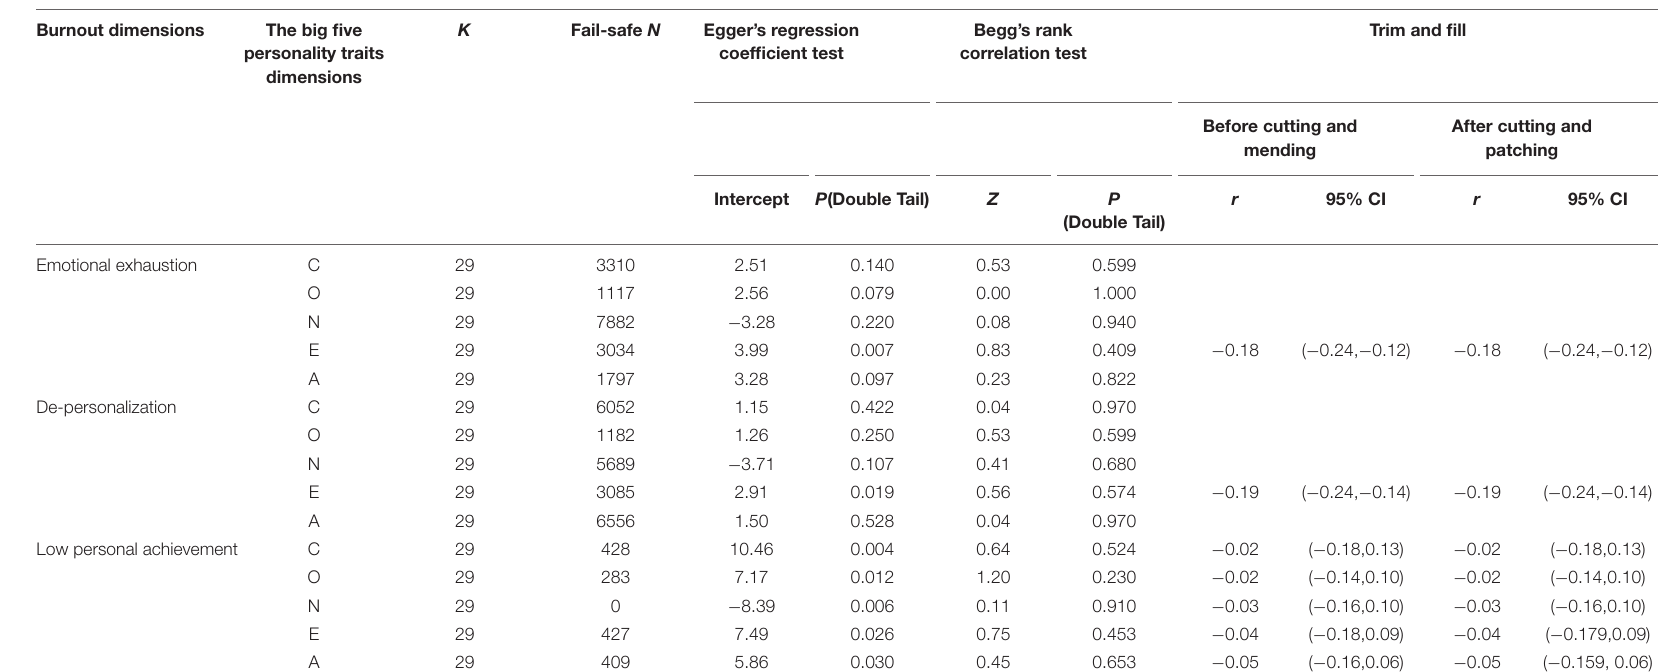
TABLE 4 | Publication bias test